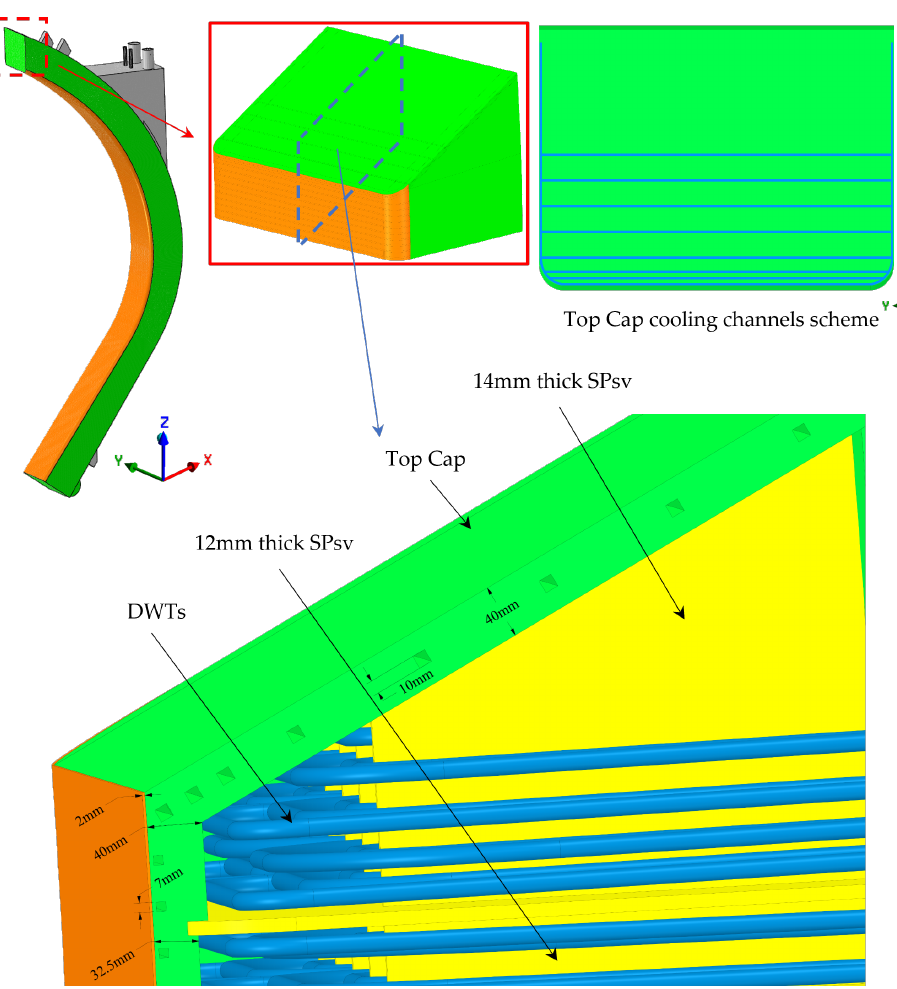
Figure 2. Geometric layout and architecture of the WCLL COB TC